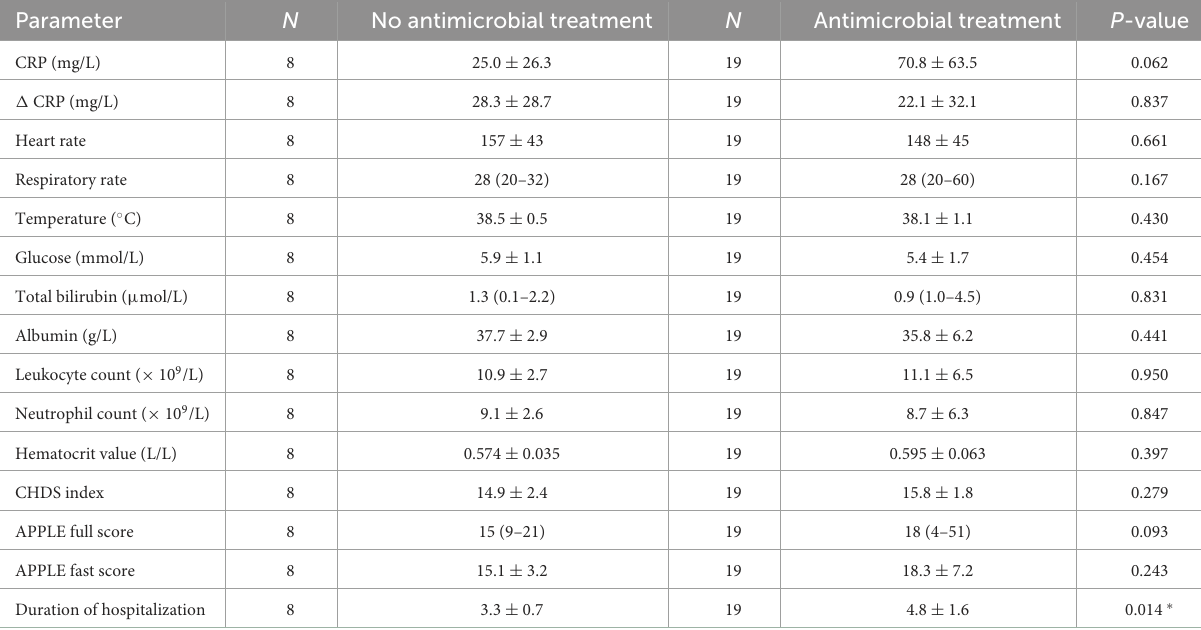
TABLE 4 Comparison of different parameters at presentation between patients with and without antimicrobial treatment.